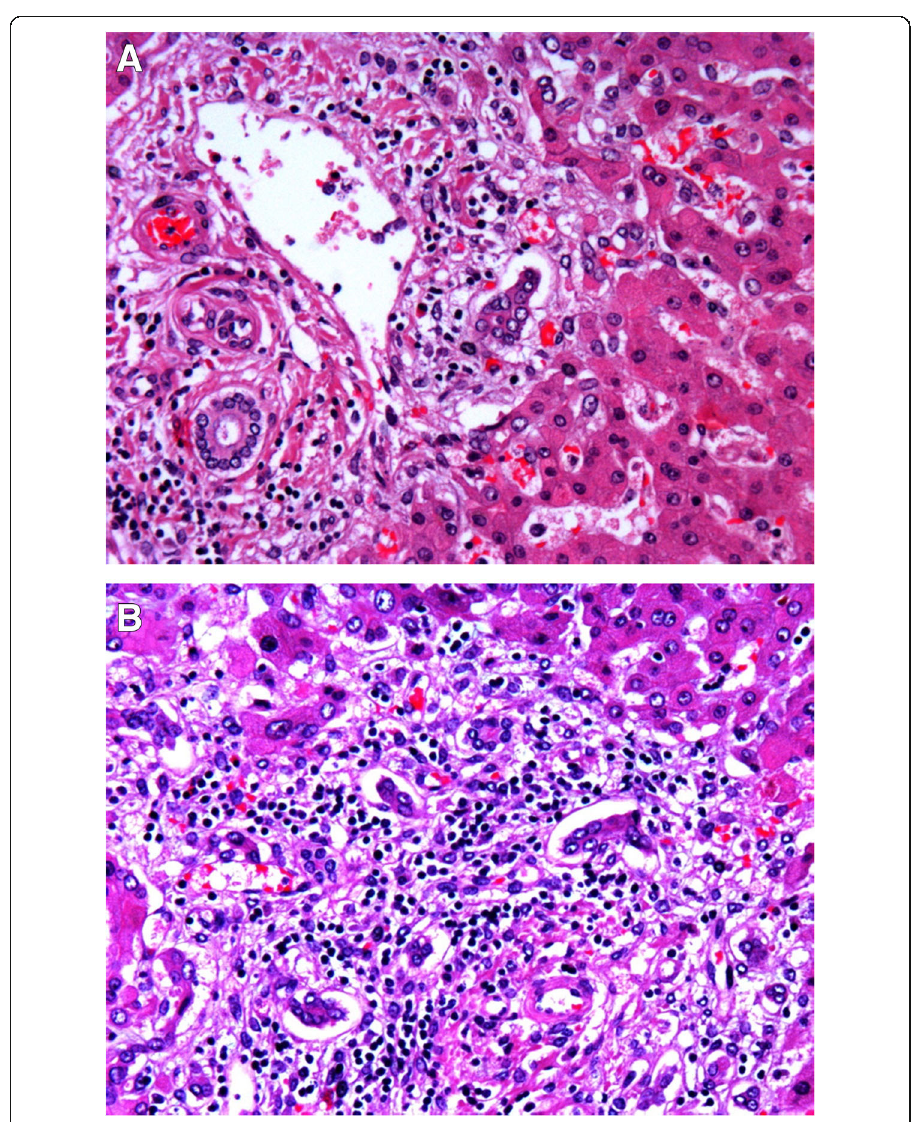
Fig. 2 Liver tissue sample from a patient with sepsis. a Signs of periportal inflammation are observed. b Signs of